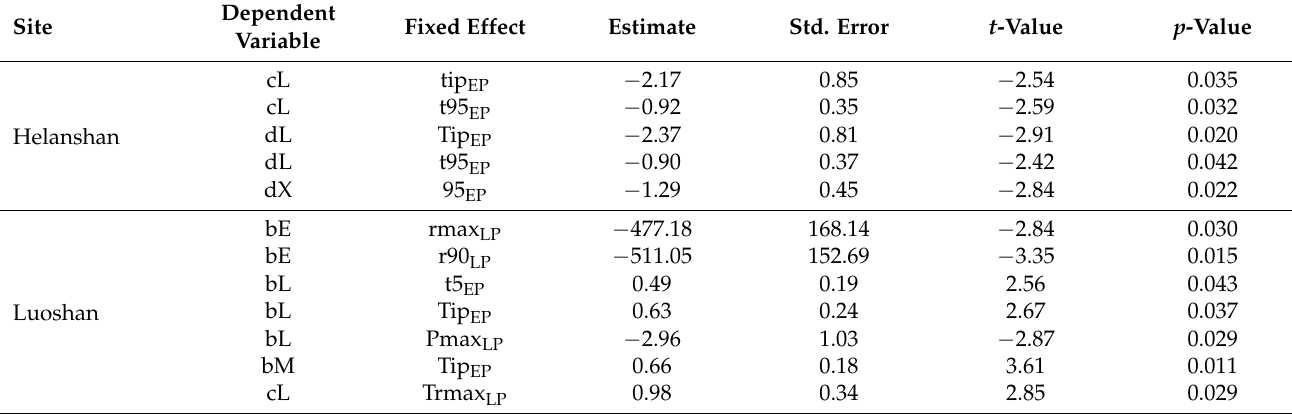
Table 5. Significant relationships between xylem and phloem formation of Picea crassifolia at Helanshan and Luoshan in Ningxia,